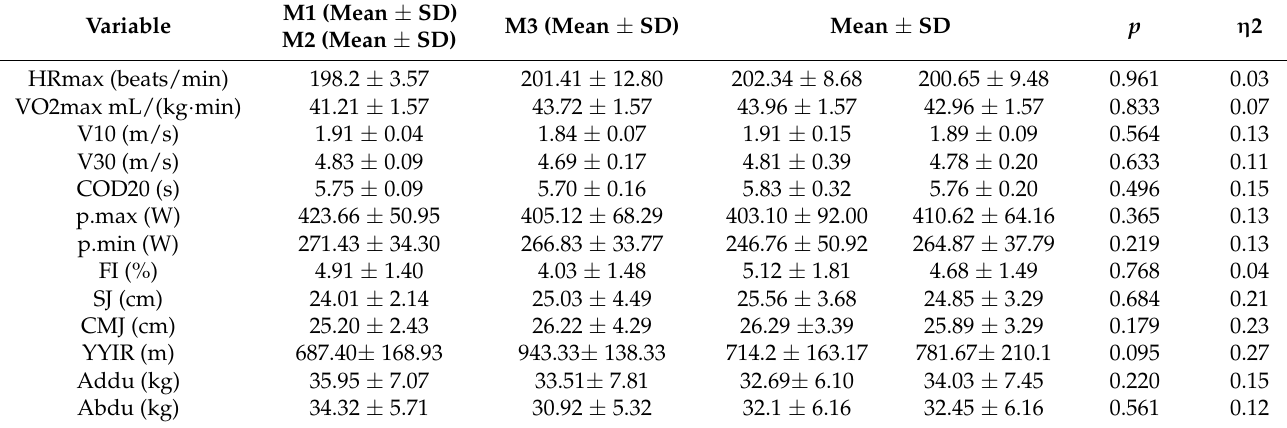
Table 1. Descriptions, F-statistics, and p -values of the fitness variables analyzed at the three moments of fitness assessment. Variable